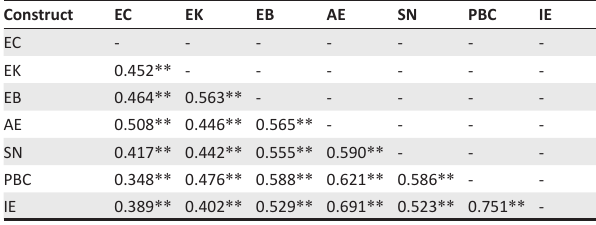
TABLE 5: Correlation